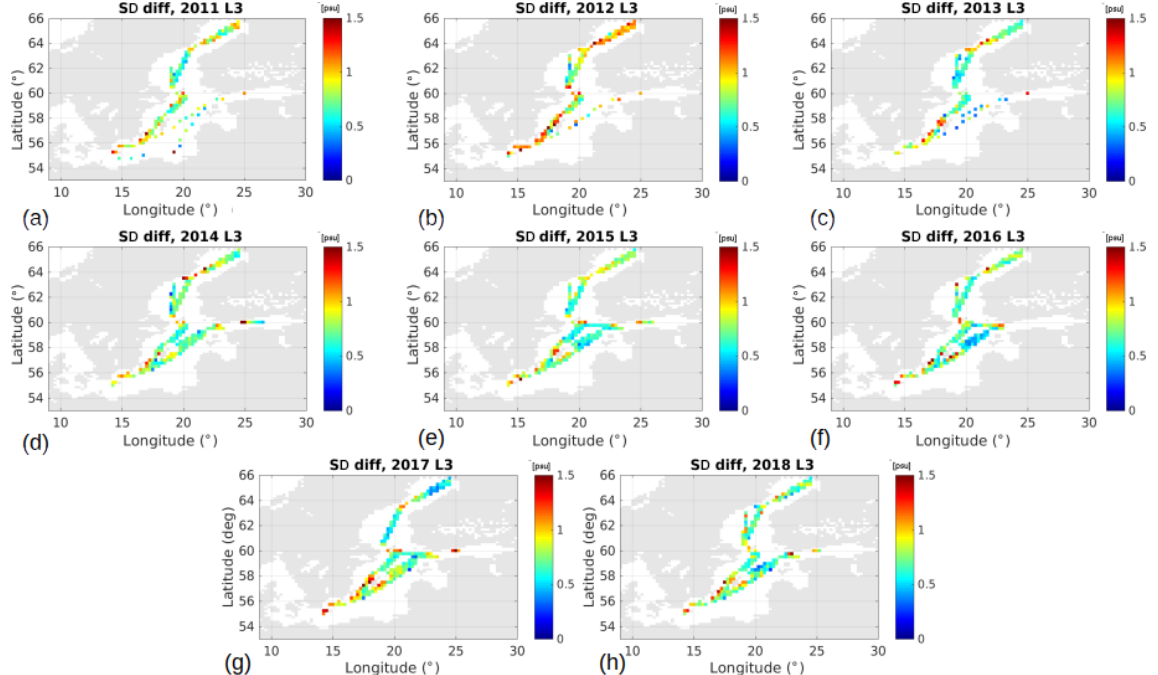
Figure 15. Comparison of L3 SSS and ferry data: spatial distribution of the standard deviation of (cid:49) SSS [psu] per year (from a 2011 to h 2018).